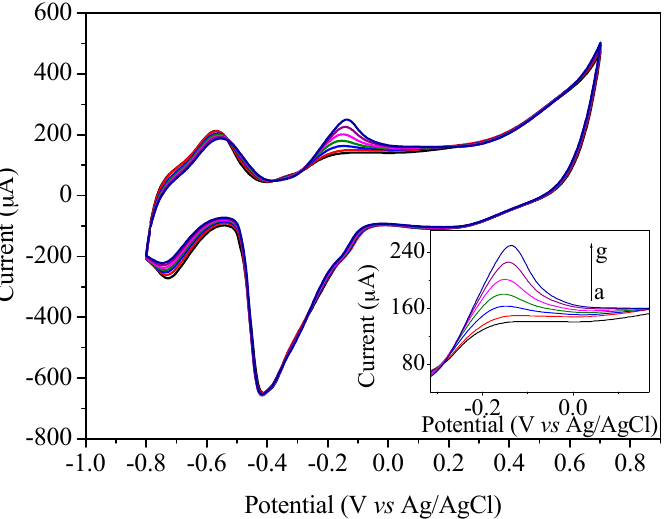
Figure 4. The cyclic voltammograms for different glycerol concentrations using Au@Pd/rGO/GCE in 0.030 mol L − 1 KOH at a 50 mV s − 1 scan rate. Voltammograms a–g are related to the glycerol concentrations at 0, 18.2, 36.5, 54.7, 73, 91.2, and 109 µmol L − 1 , respectively.